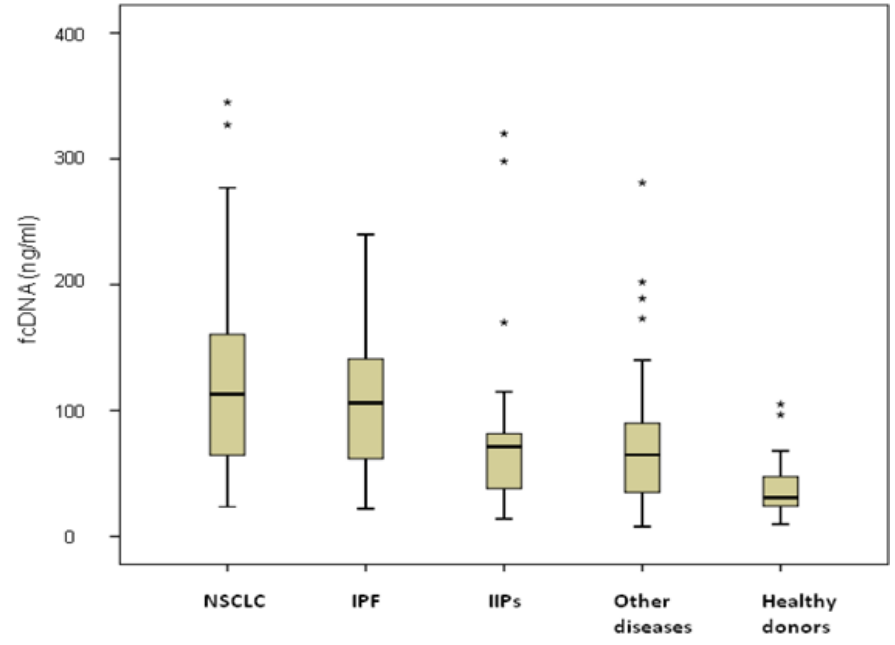
Figure 1. Free circulating DNA levels in healthy donors and patients with different lung diseases. The asterisks stand for outliers, i.e . observation points that are distant from other observations.